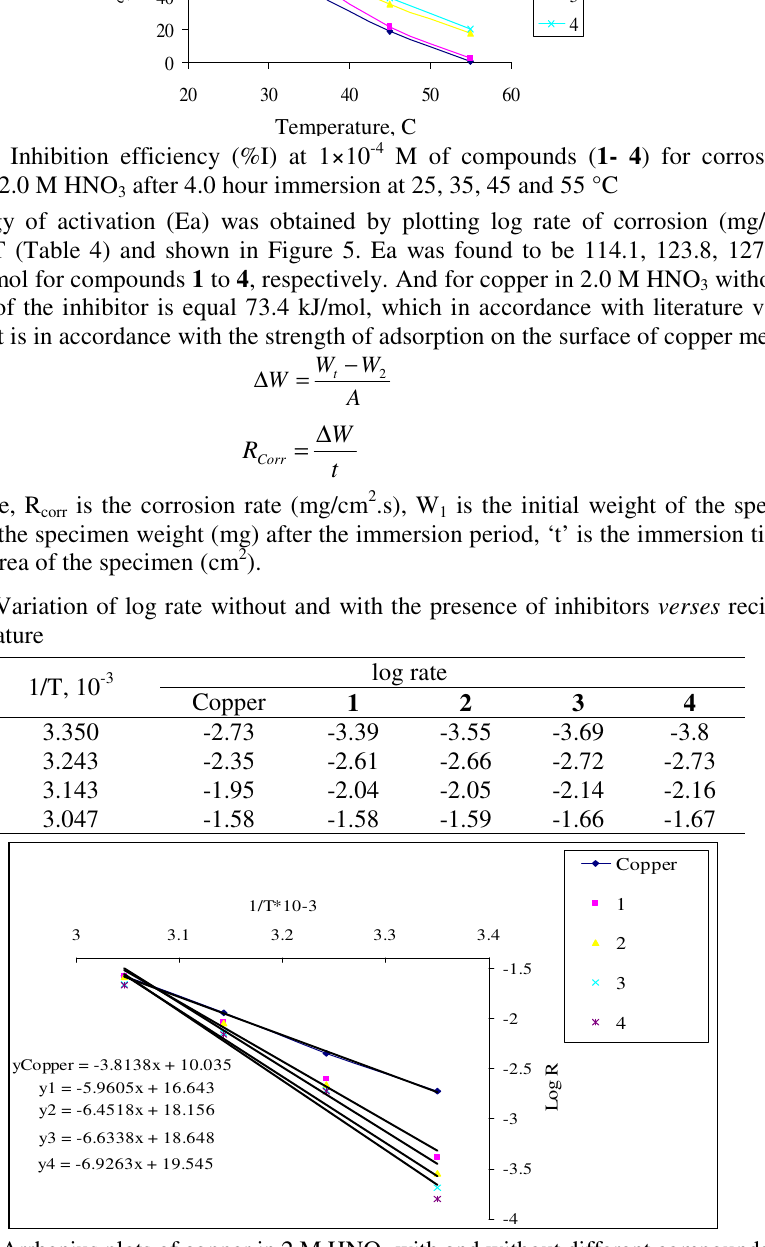
with and without different compounds ( 1-4 3